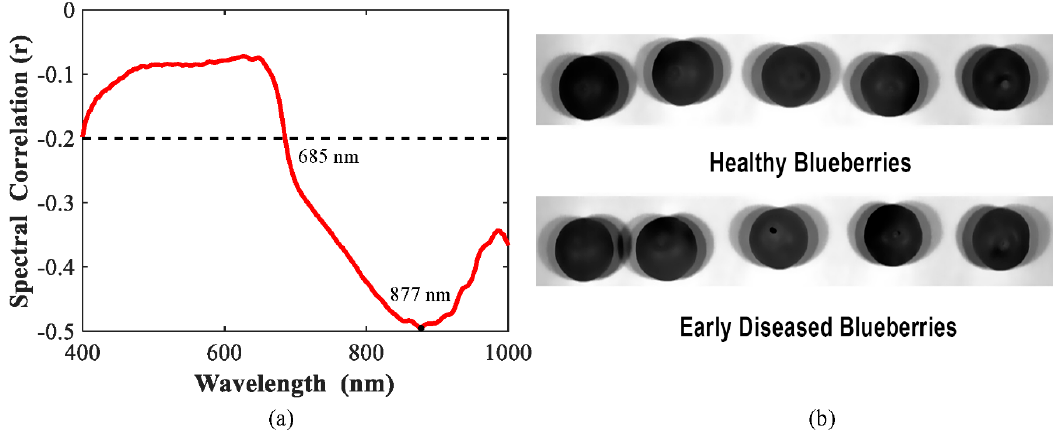
Figure 4. Correlation curves for blueberry between grading class and relative reflectance of individual wavelengths for the visible and shortwave near-infrared region of 400–1000 nm ( a ), and the hyperspectral images for healthy and early disease blueberries in 877 nm ( b ).